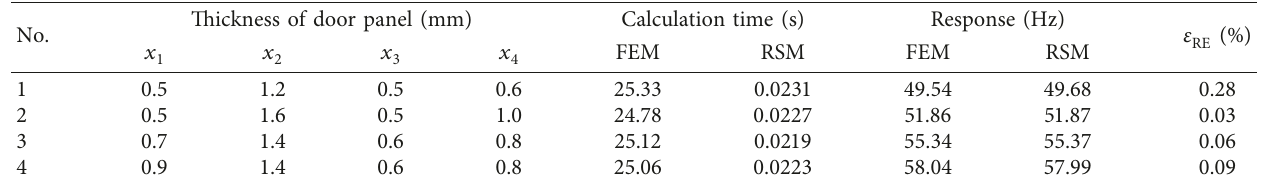
Figure 6: Values of objective function and design variables with respect to iteration process. (a) Values of design variables. (b) Values of objective function. Table 6: Results of computational times and relative errors at experimental